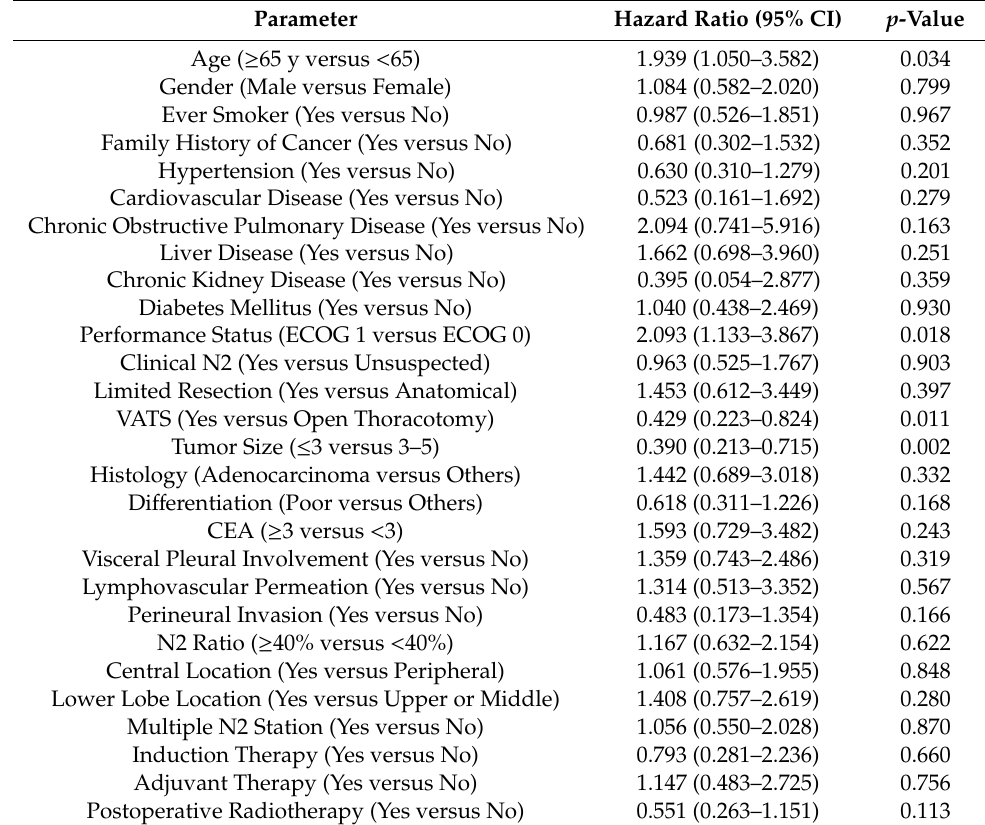
Table 2. Univariate analysis of factors associated with overall survival.